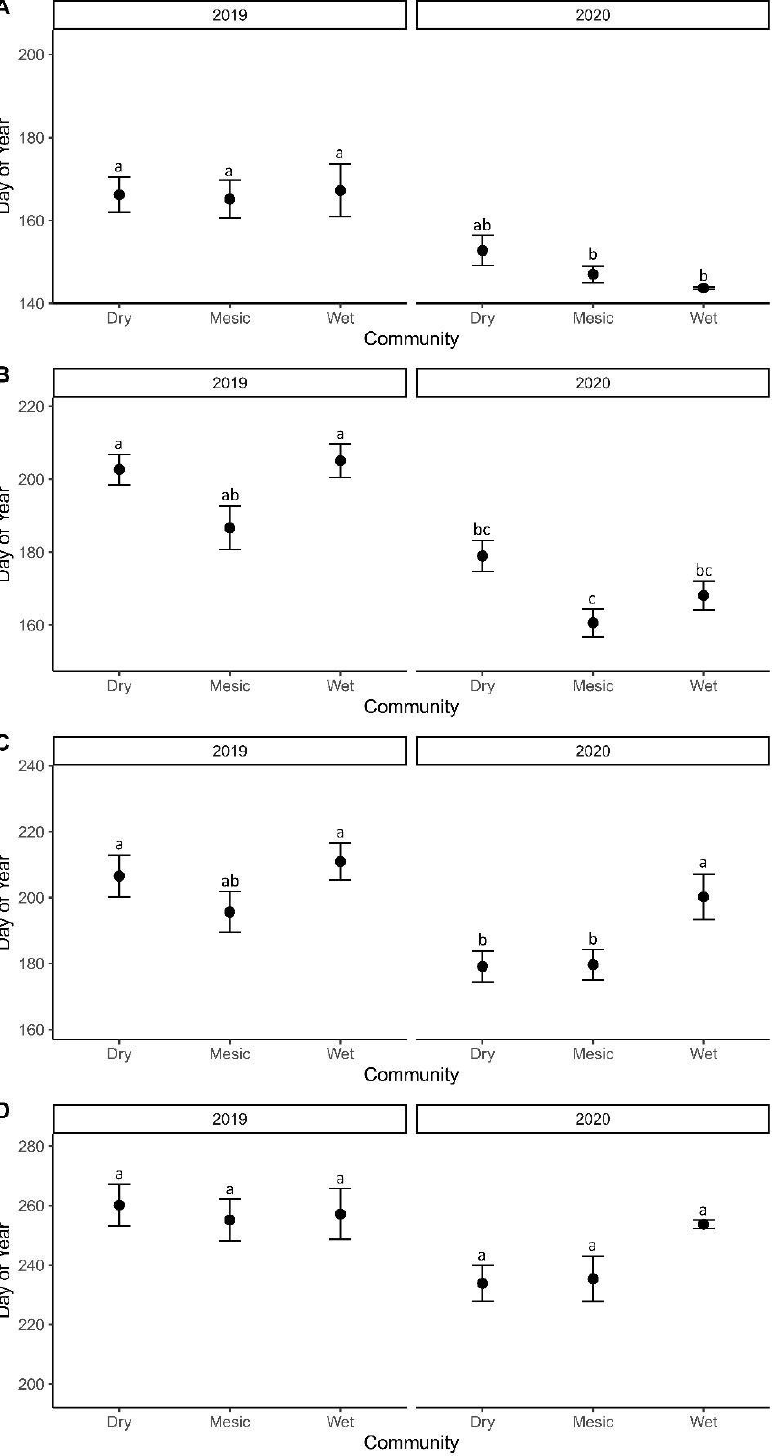
Figure 6. Mean ( ± SE) phenology values across vegetation communities and years. Phenology stages are ( A ) leaf growth (L), ( B ) inflorescence (I), ( C ) seed (S), and ( D ) desiccated (D). Different letters indicate significant differences.